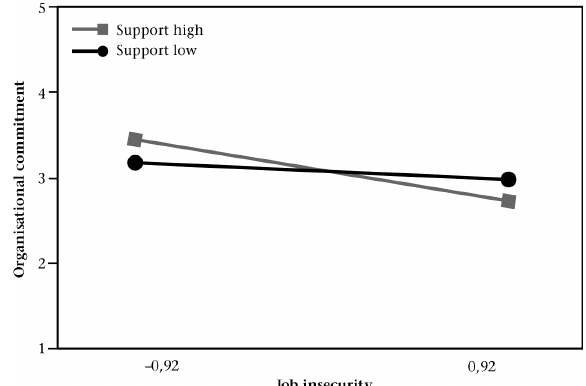
Figure 2: Organisational commitment as a function of perceived union support and job insecurity for the Swedish